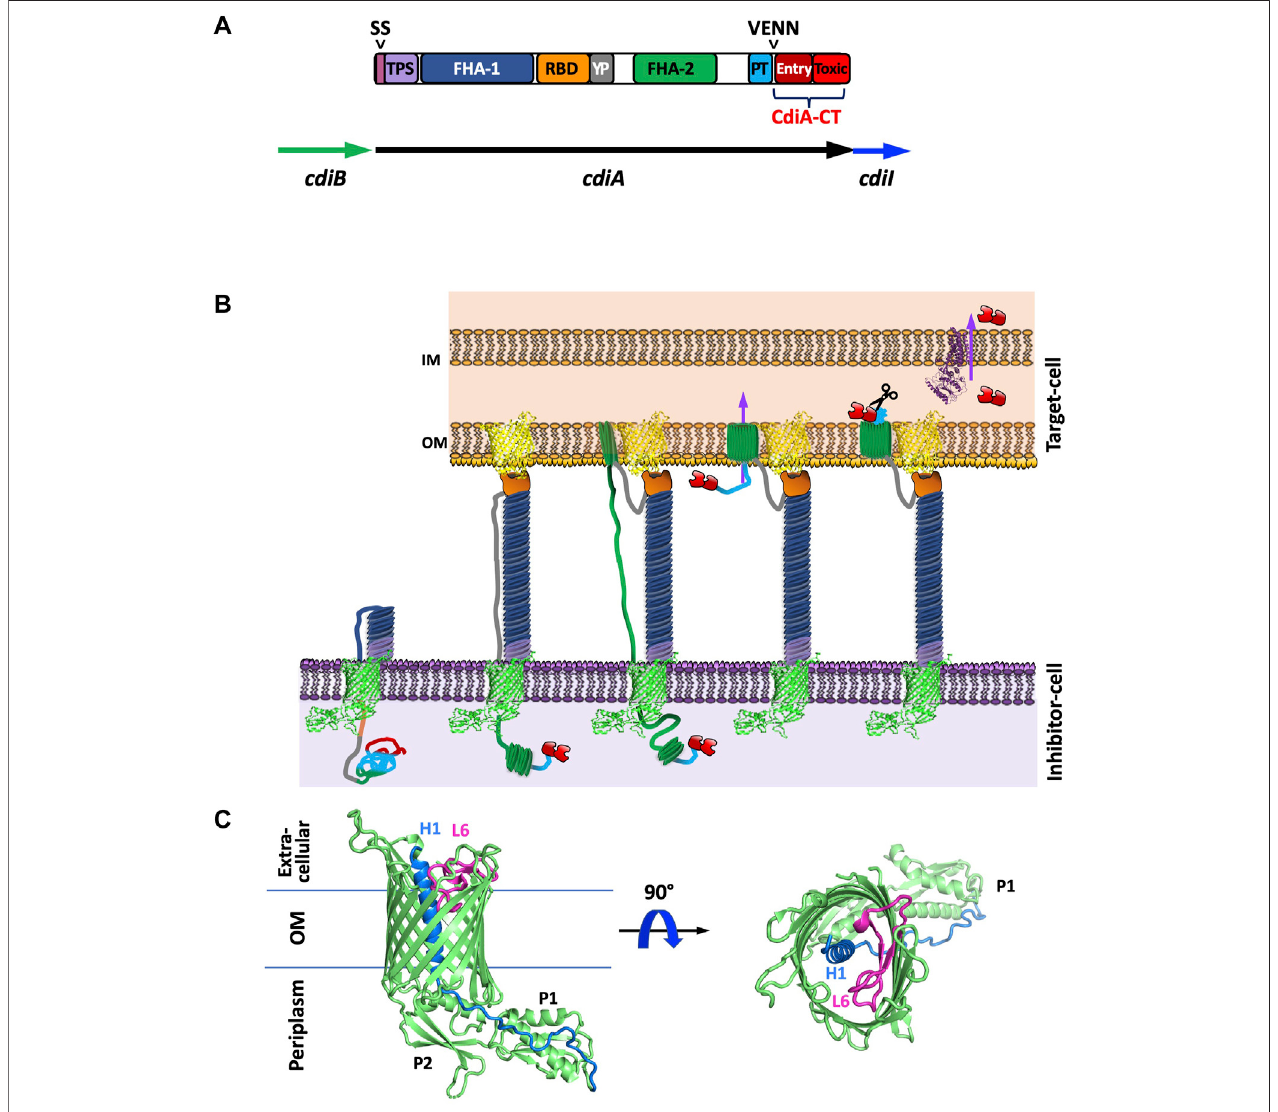
FIGURE 1 | Introduction to CDI proteins and a working model ofCDI toxin translocation. (A) Domain architecture of CdiA and organization ofthe cdi locus. CdiA is colored by domain, including the secretion signal (SS), two partner secretion (TPS) domain, FHA-1, receptor-binding domain (RBD), tyrosine-proline rich domain (YP), FHA-2,pretoxin(PT)domain, VENNmotif,andCdiA-CTentrydomainandCdiA-CTcytotoxic(Toxic)domain. (B) SchematicofCDI.CdiB(green)presentsCdiA(colored bydomainasinA)ontothesurfaceoftheinhibitorcell.WhentheCdiA-RBD(orange)recognizesitstarget-cellreceptor(yellow),CdiAsecretioncontinues,andFHA- 2 (dark green) translocates CdiA-CT (red) into the target-cell. Once in the target-cell periplasm, the CdiA-CT is cleaved after the PT-motif, the entry domain recognizes a speci fi cinnermembranereceptor(purple)andthecytotoxicdomainistranslocatedacrosstheinnermembraneintothecytosol. (C) StructureofCdiB.CdiBisanOMP β - barrel. Key components like α -helix H1 (blue) and loop L6 (pink) are highlighted [PDB ID 6WIL (Guerin et al., 2020)].